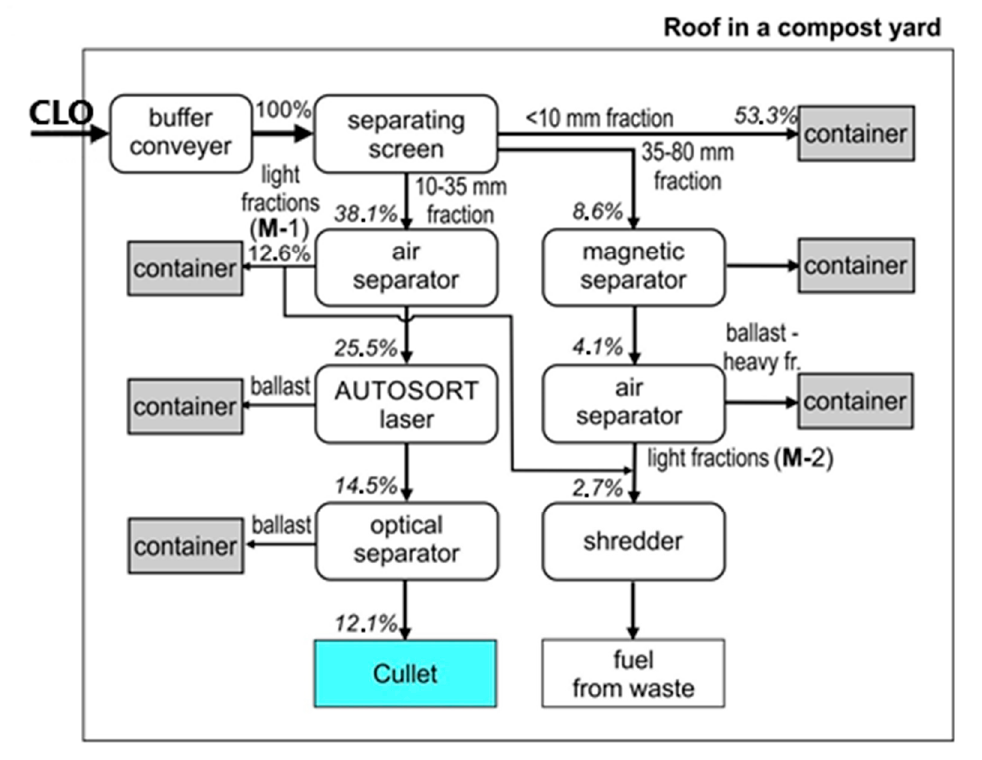
Figure 1. Technological scheme of the compost-like-output (CLO) processing line (material balance for Marszów waste).